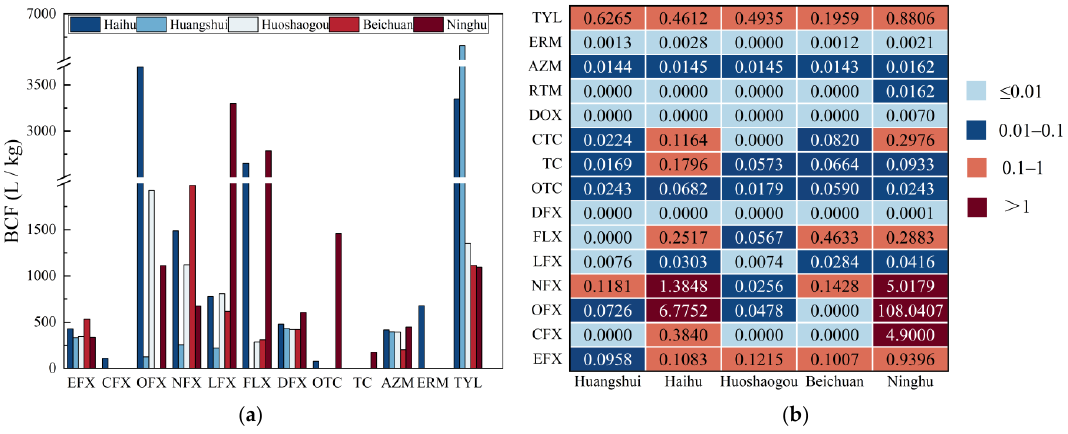
Figure 4. ( a ) Bioconcentration factors (BCF) of antibiotics in HNWP; ( b ) Risk quotients (RQ) of antibiotics in each wetland of HNWP.